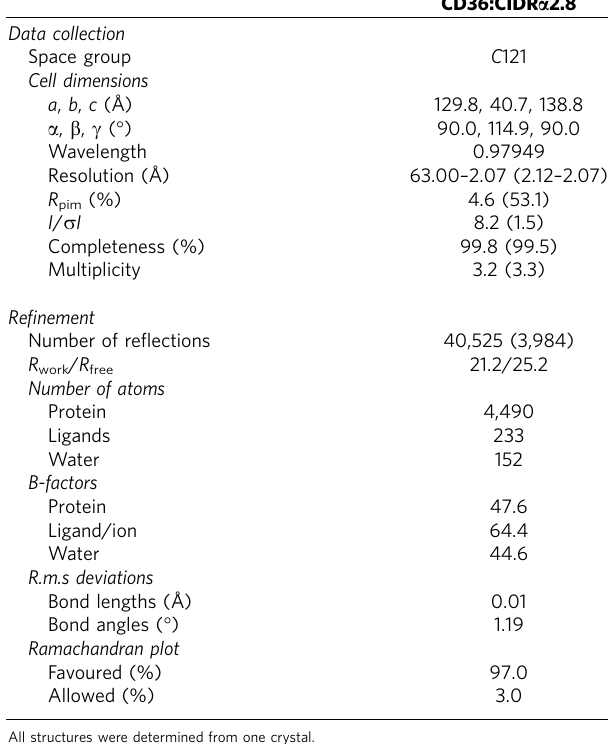
Table 1 | Data collection and refinement statistics.